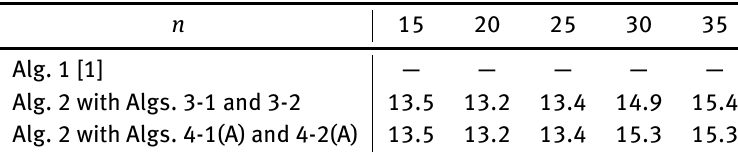
Table 8: Numbers of iterations of Algorithms 1 and 2 for T with random matrices A , B , C and the size of T is n 3 × n 3 . The symbol “—” means that the algorithm did not converge to the minimum singular values of T .